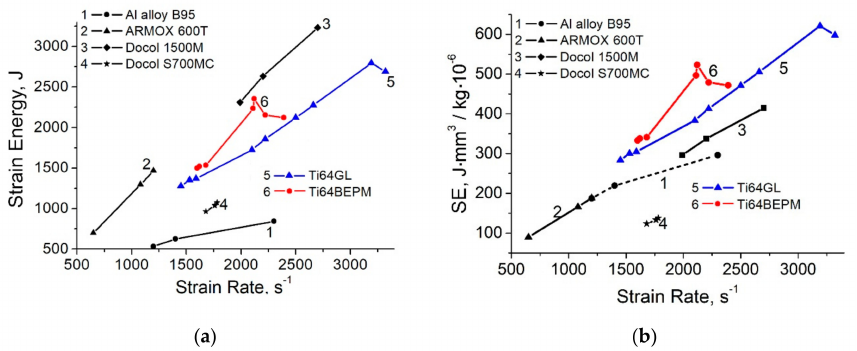
Figure 7. Comparison of the SE-strain rate dependencies for di ff erent materials: ( a ) absolute values of the SE; ( b ) relative (specific) values of the SE. The data used for the curves 1–4 were taken from